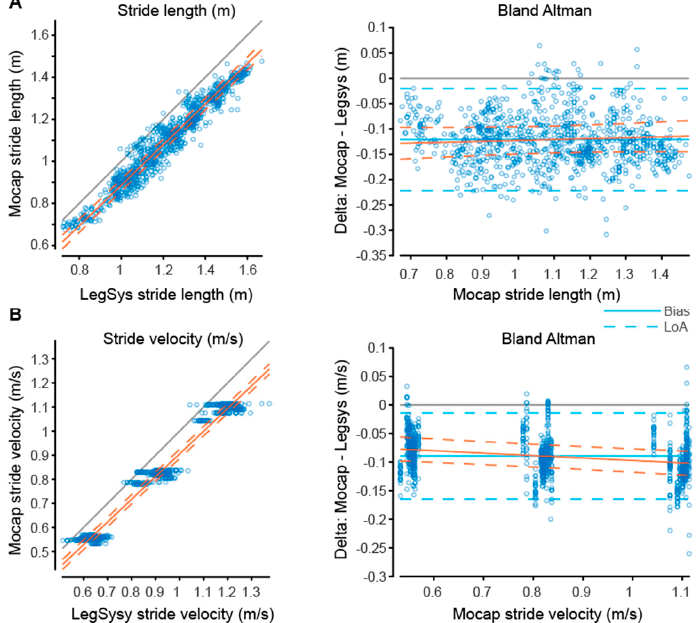
Figure A1. Scatter and bland-Altman plot of MOCAP vs. LEGSYS for stride length (m) and stride velocity (m/s). Part A and B shows the scatter plot and bland-Altman plot on the left and right, respectfully for each parameter. For the scatter plot, the blue dots show stride length or stride velocity for each system. The bland-Altman plots show the difference between the MOCAP and LEGSYS parameters on the Y axis and MOCAP stride length or velocity. Blue line and dotted blue line show the bias and limits of agreement respectfully. The orange line on all 4 plots shows the least squares regression lines with orange dots being the 95% confidence interval.